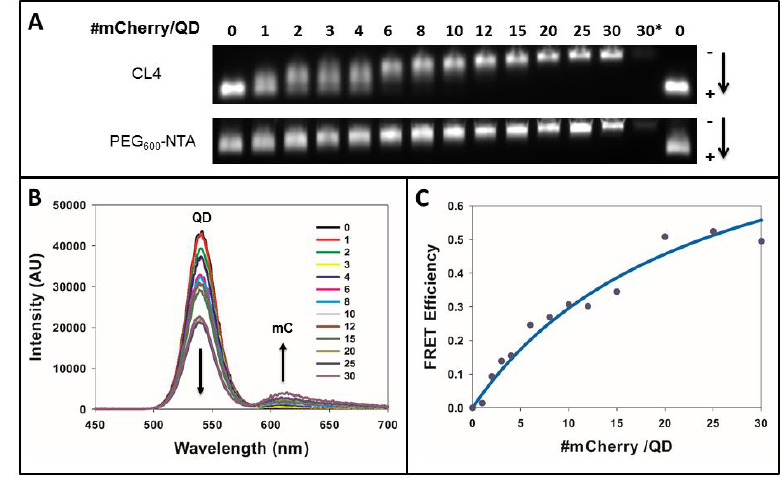
Figure 2. Assembly and FRET analysis of the QD-mCherry (mC) donor–acceptor pair. ( A ) The 545 nm-emitting QDs capped with CL4 or PEG 600 -NTA were assembled with increasing ratios of mCherry and separated on 1% agarose gels; ( B ) Emission spectra of CL4 capped 550 nm QDs showing sensitization of QD donor emission with increasing ratio of mCherry acceptor. Data have been corrected for direct excitation of mCherry; ( C ) Plot of QD-mCherry FRET efficiency as a function of increasing QD-mCherry ratio. Line is fit to Equation